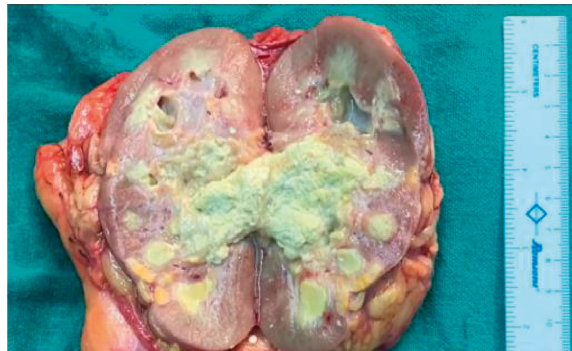
Figure 2: The cut section of the right kidney shows cheesy material infiltrating the renal pelvis and